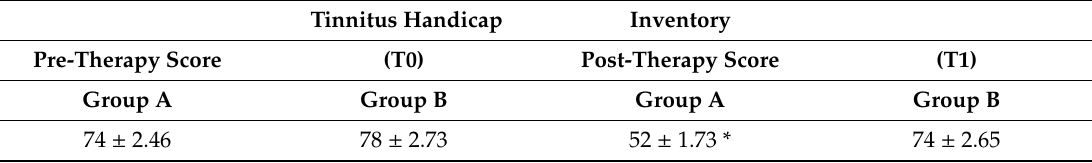
Table 3. Tinnitus Handicap Inventory